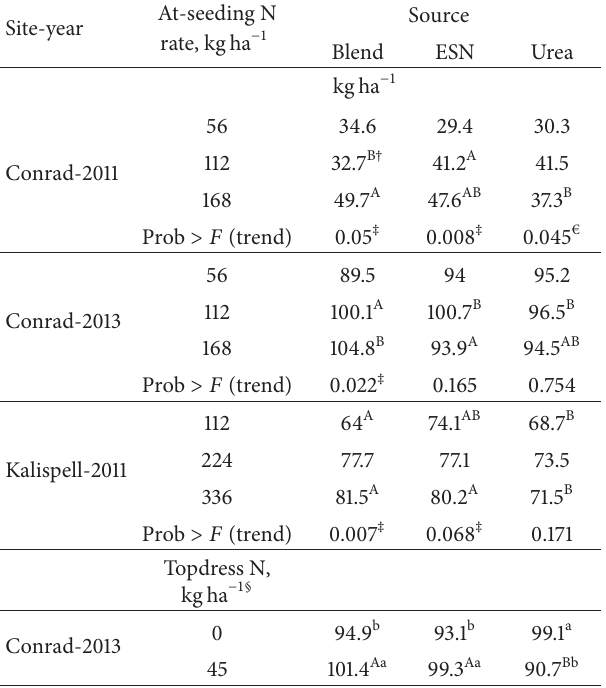
Table 7: Simple effects of two-way interactions of source by at- seeding and topdress N rates for N uptake from selected site-years where interaction effect was significant at least at 𝑝 < 0.1